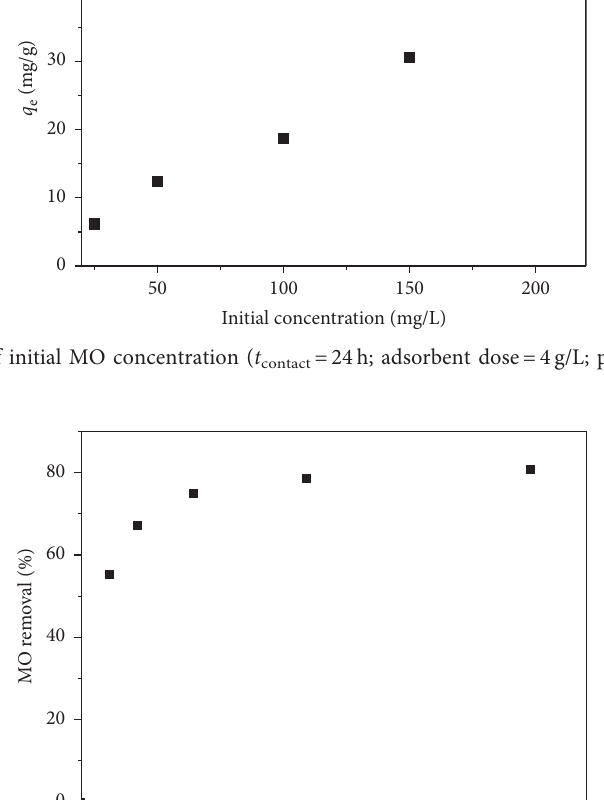
� 24h; C � 100mg/L; pH � 7.21; T � 22 ° C). contact 0